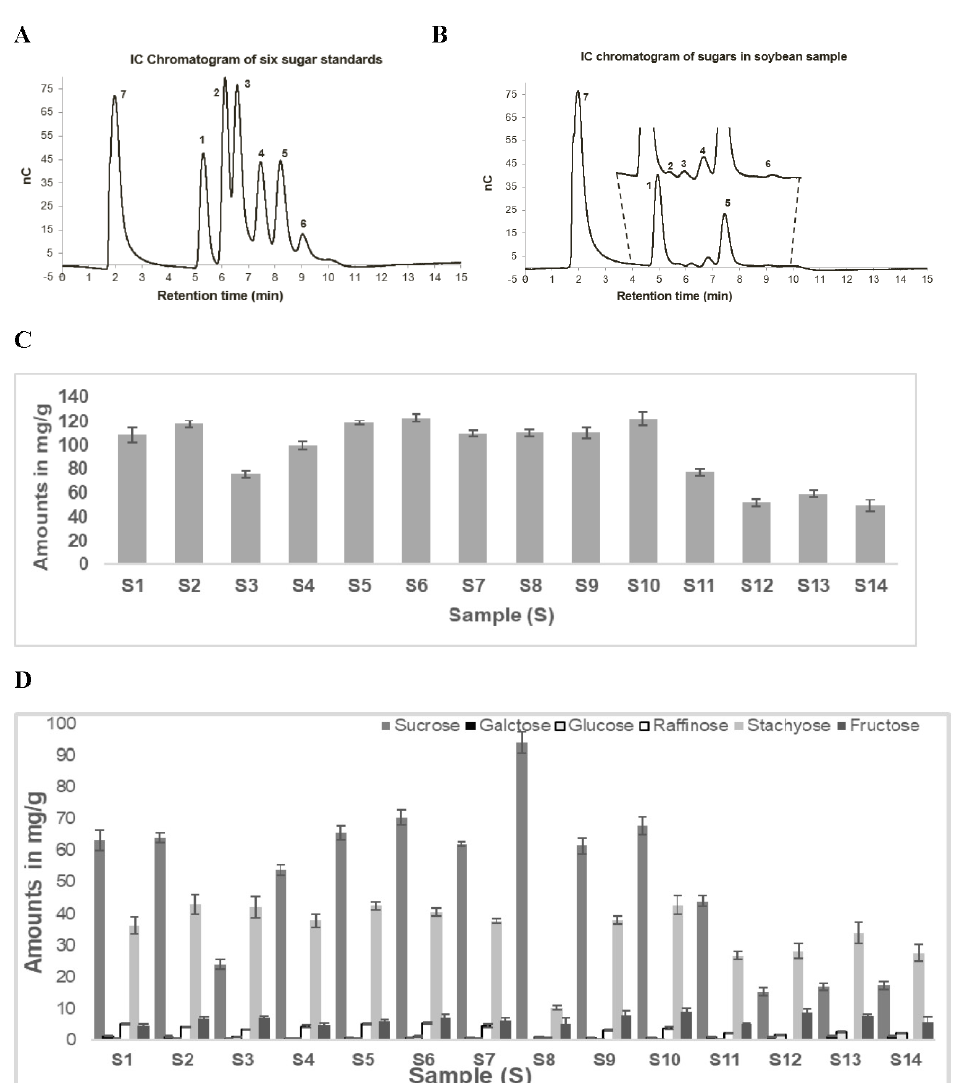
Figure 4. A representative chromatogram depicting the separation of sugars (Sucrose 1 , Galactose 2 , Glucose 3 , Raffinose 4 , Stachyose 5 , Fructose 6 ) and the internal standard (Xylitol 7 ). ( A ) Six sugar standards, ( B ) sugars extracted from a soybean sample, ( C ) total soluble sugar content, and ( D ) individual soluble sugar profiles of 14 soybean samples. All extractions and analyses were performed in triplicate and the error bar represents standard deviation between three or four replicate analyses. IC, ion chromatography.